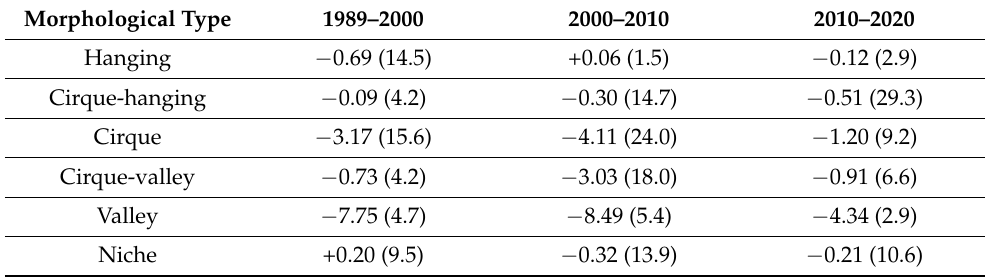
Table 7. Decrease of the glaciers of Tavan Bogd of different morphological type, km (%). Morphological Type